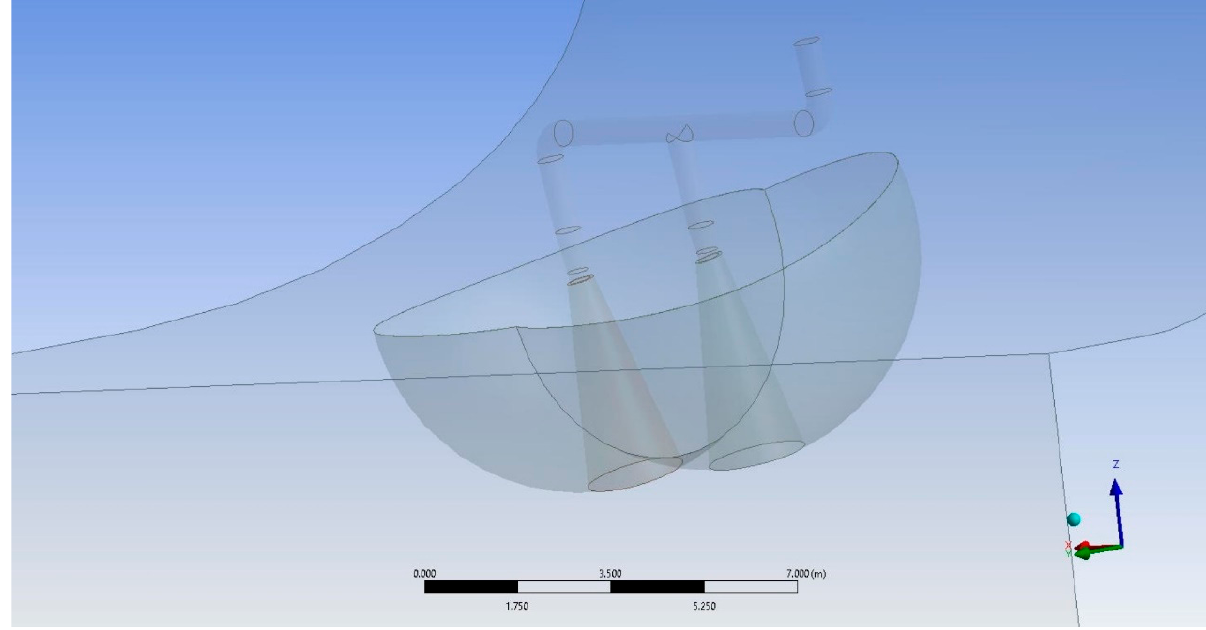
Figure 1. Spherical volumes in CFD simulation.